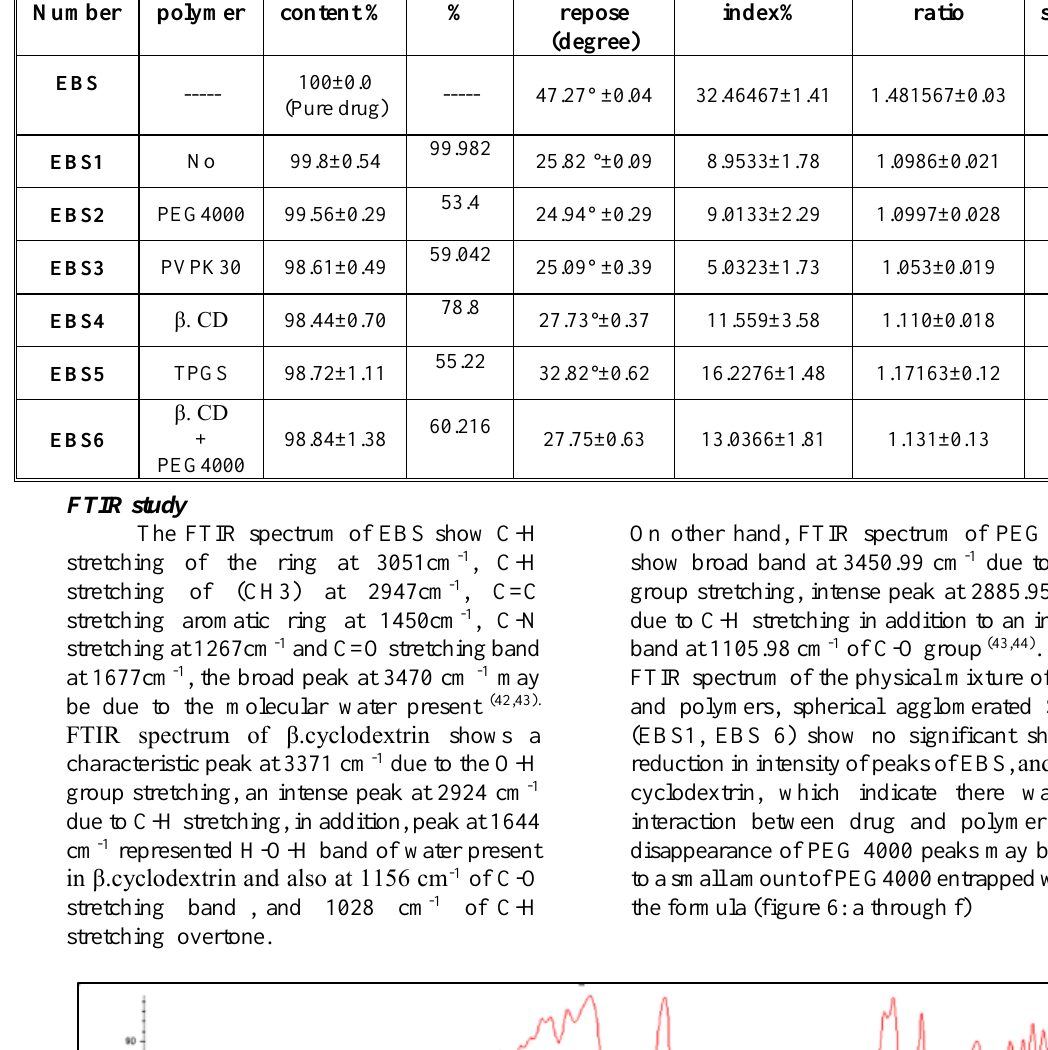
Table 2. Drug content, %yield and micromeritic property of pure and SCAs of ebastine